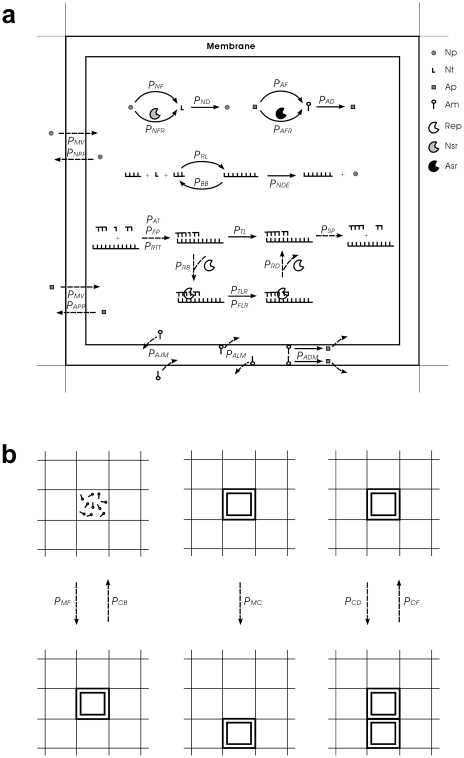
Events occurring in the model and their associated probabilities.Solid arrows represent chemical events and dashed arrows represent other events. (a) The events occurring in a grid room. Legends: Np, nucleotide precursor; Nt, nucleotide (A, U, C, or G); Ap, amphiphile precursor; Am, amphiphile. This version is for the true-protocell system. For the pseudo-protocell system, the events concerning Asr would not occur. For the naked system, the events concerning amphiphilic molecules and their precursors would not occur; there is no membrane at the edge of the grid room; nucleotides and RNA may also move to an adjacent grid room (see Table 1, note b). (b) Events concerning the behaviors of the protocells. When a protocell move to an adjacent (top, down, left, or right) naked grid room, the protocell would push away molecules in that room. When a protocell divides, amphiphiles on the membrane and molecules in the protocells would be distributed randomly between the two offspring protocells. One of the offspring protocells would occupy an adjacent naked grid room and push away molecules in that room.